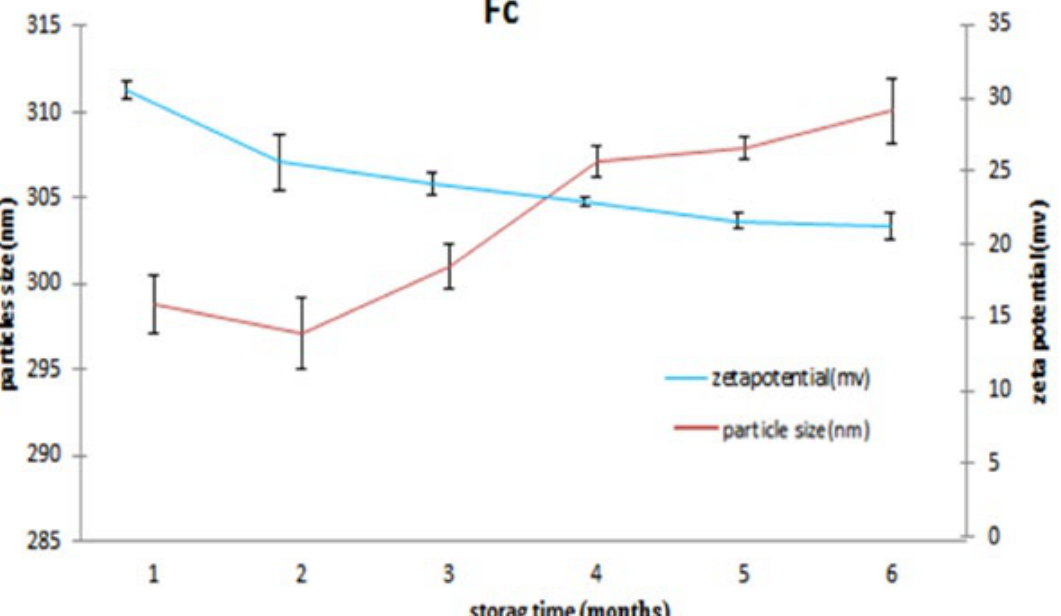
FIGURE 8 - Particle size and zetapotential of reconstituted Fc(chitosan/TPP nanoparticles) upon storage for 6 months at room